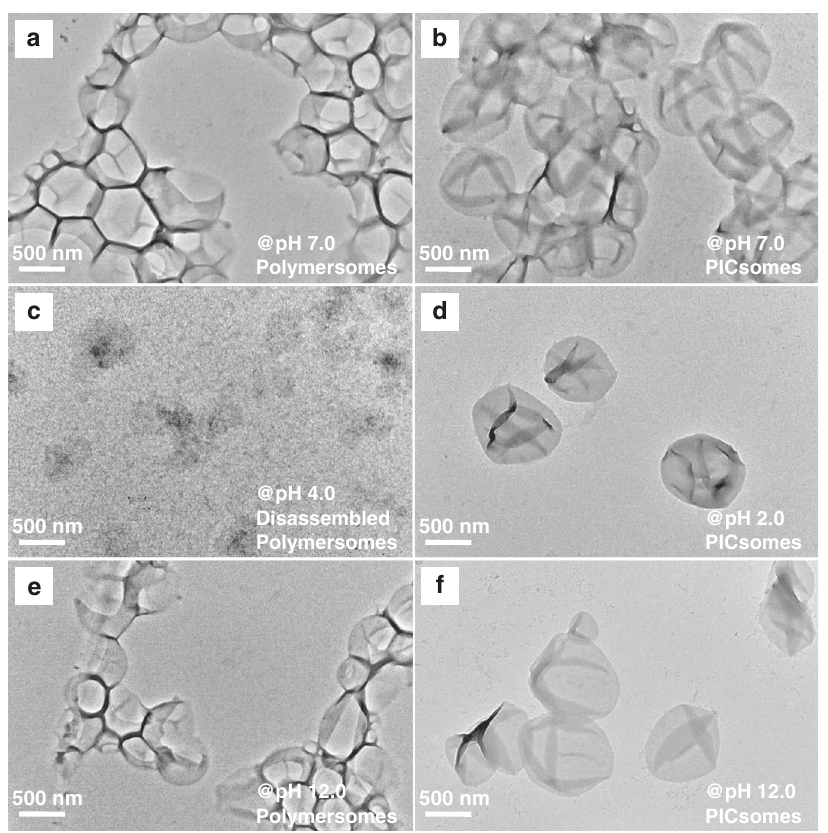
Fig. 3 TEM images of PEO 45 - b -P(NCMA 0.55 - co -DPA 0.45 ) 29 polymersomes and corresponding PICsomes. Original polymersomes a and PICsomes obtained after 10 min UV irradiation in neutral aqueous media b ; c , e Polymersomes after being subjected to pH 4.0 and pH 12.0, exhibiting microstructural destruction in acidic media; d , f PICsomes in aqueous media at pH 2.0 and 12.0.